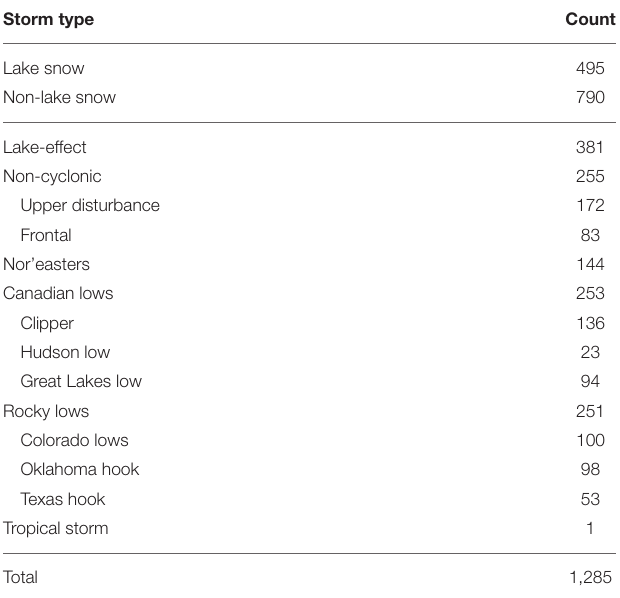
TABLE 1 | Number of snowstorms per storm type to affect Central New York from the 1995/96 season to the 2014/15 season.